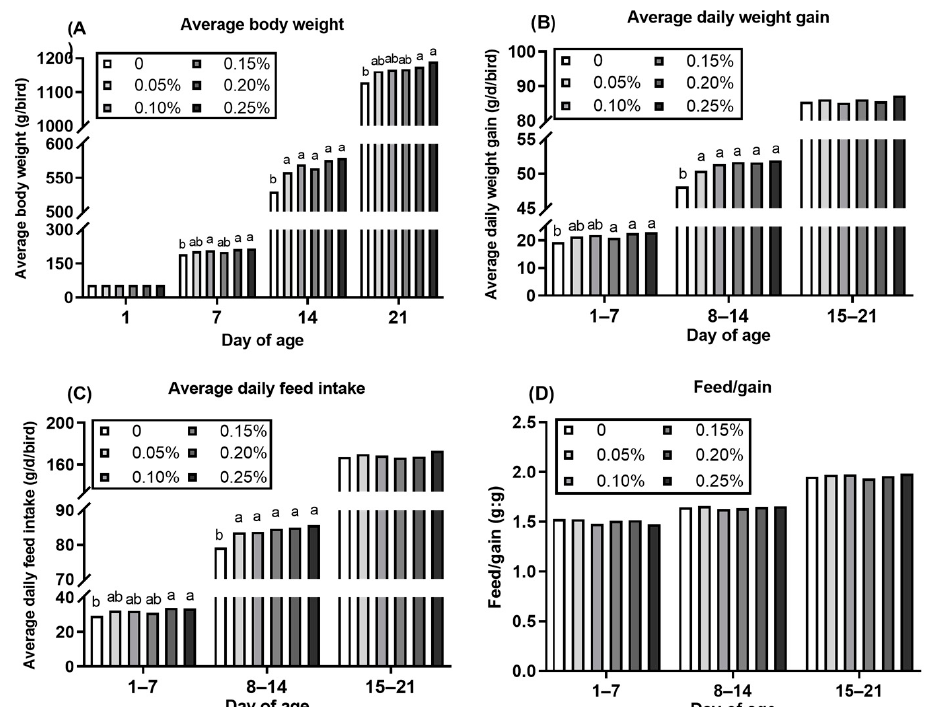
Figure 2. Effect of dietary methionine concentration on growth performance of starter Pekin ducks